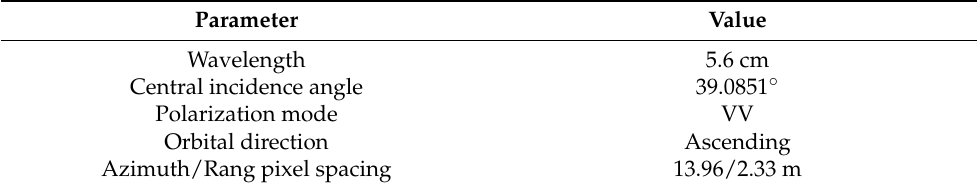
Table 1. Detailed parameters of the Sentinel-1A